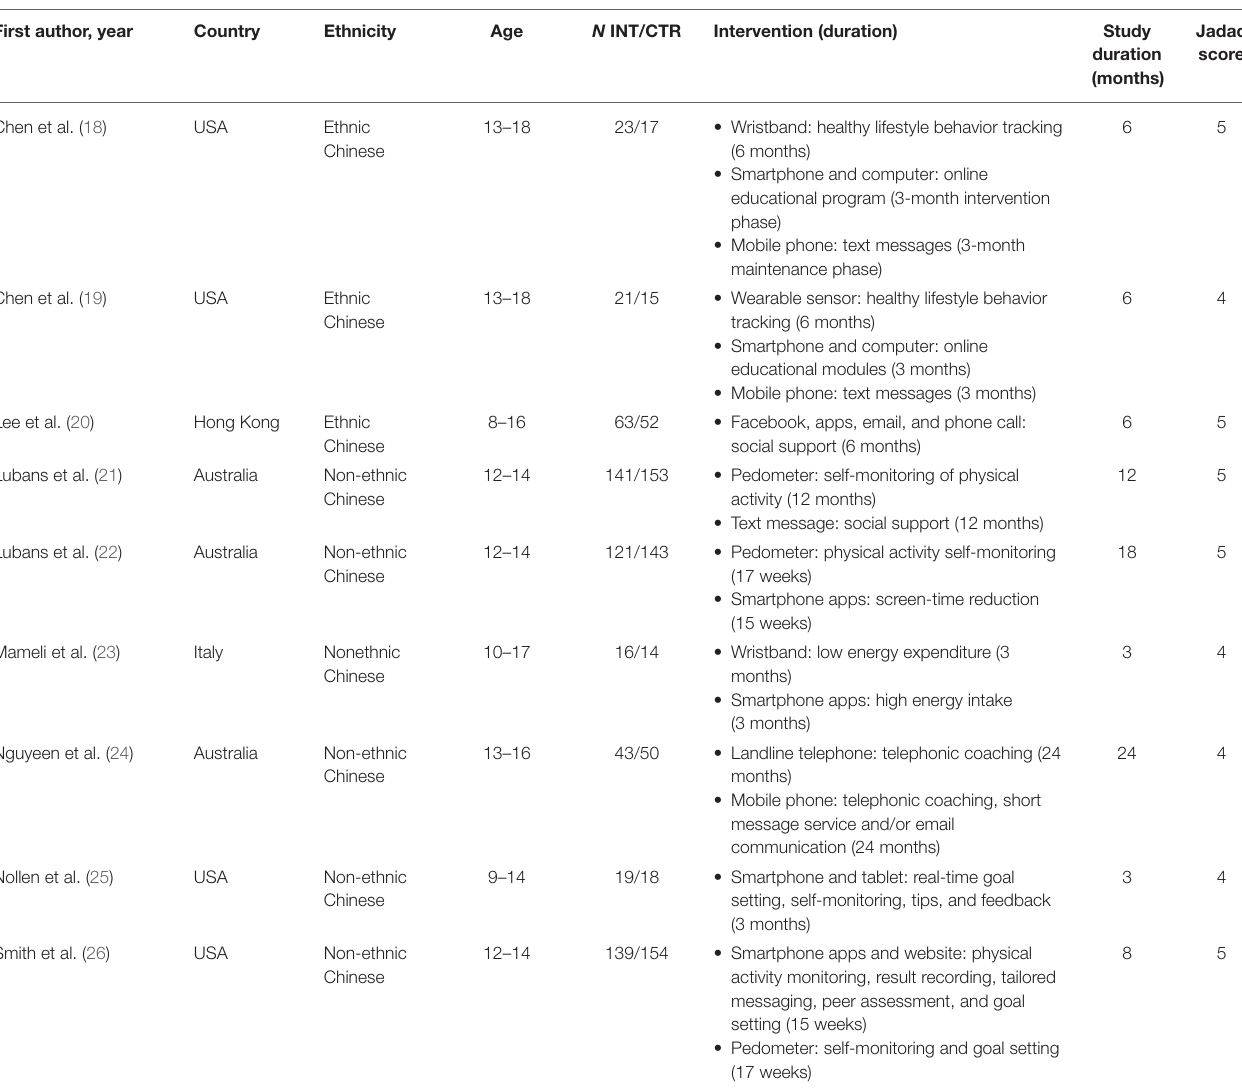
TABLE 1 | Characteristics of the studies